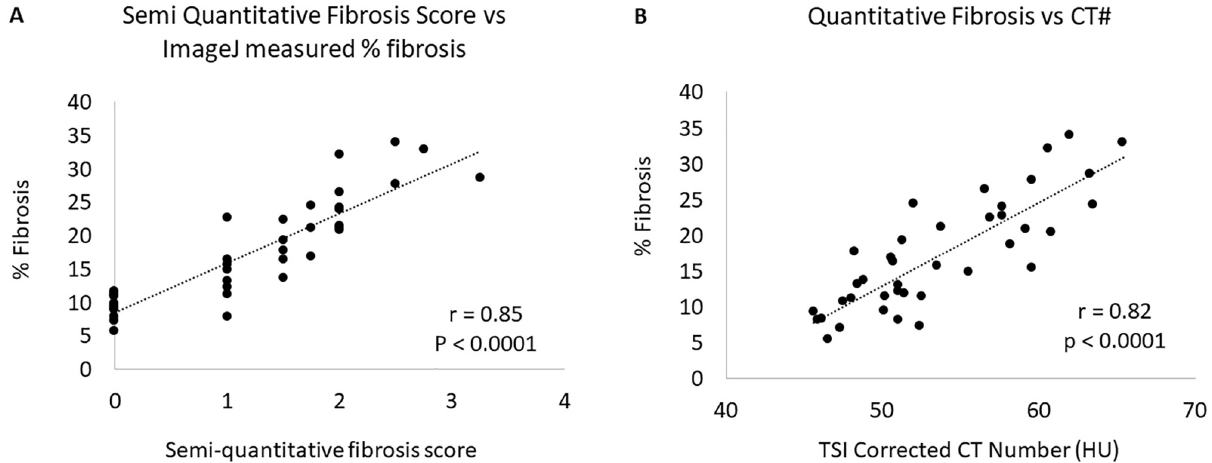
Fig 6. Correlation of tissue fibrosis scoring with size corrected CT HU. A) Quantitative color threshold scoring of blue-stained fibrosis correlates well with semiquantitative human scoring and B) also with size-corrected CT number.